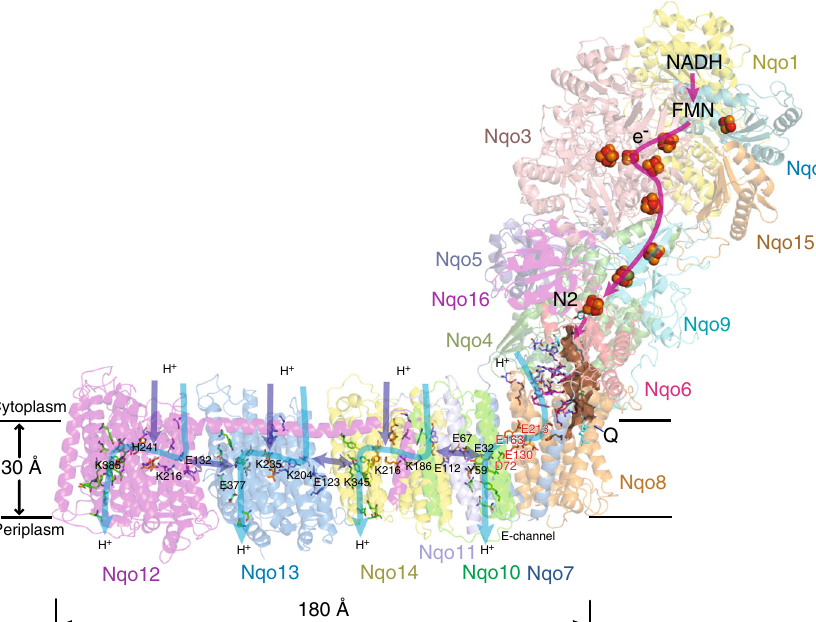
Fig. 1 Overall structure and organization of Thermus thermophilus complex I. The electron transfer pathway in the peripheral arm (PA) and putative proton translocation pathways in the membrane domain (MD) are indicated by arrows. Complex I subunits are coloured individually and labelled. Fe – S clusters are represented as spheres, with cluster N2 labelled. The quinone is shown as cyan sticks within the quinone-binding cavity (brown surface). The position of its headgroup is based on our DQ data, but the entire ubiquinone tail was modelled to illustrate the extent of the native molecule. In the proton translocation channels, polar residues lining the channels are shown as sticks with carbon in dark blue for the fi rst (N-terminal) half-channel, in green for the second (C-terminal) half-channel, and in orange for the connecting residues. Key residues for antiporter-like subunits, GluTM5 and LysTM7 from the fi rst half-channel, Lys/HisTM8 from the connection, and Lys/GluTM12 from the second half-channel, are labelled. Residues playing similar roles in the E- channel are also labelled (Glu/Asp quartet in red). The central hydrophilic axis extends from the Q site to the tip of the MD along these indicated key residues. The residues connecting quinone cavity to the E-channel are in magenta. Proton translocation pathways through symmetry-related half-channels are indicated by blue arrows, and additional possible paths (extra entry sites and inter-subunit transfer) by violet